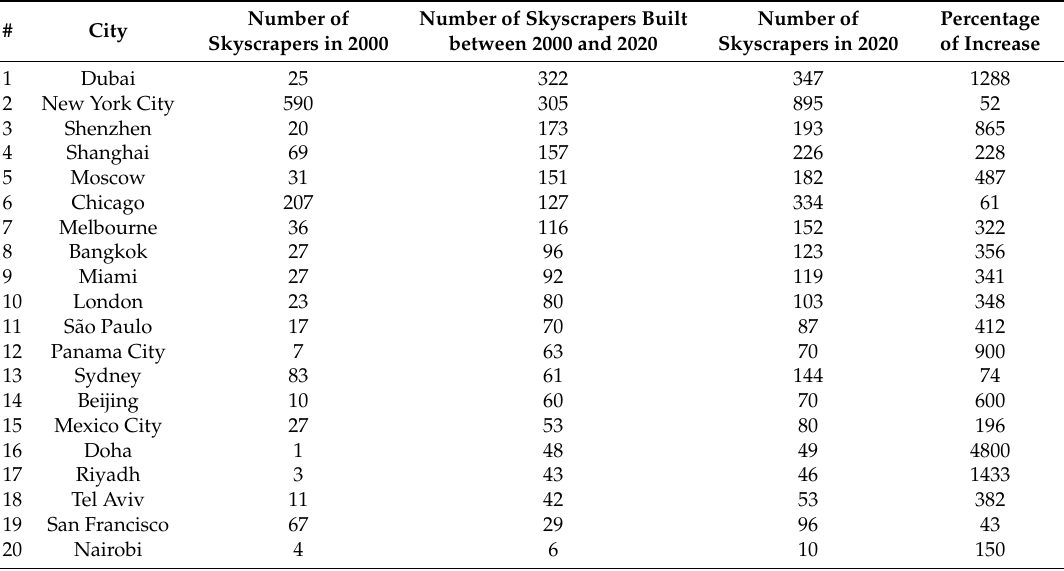
Table 33. Skyscrapers in 2000 and